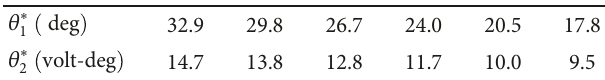
t , v t , and v t ) during closed-loop operation. 4 5 6 Table 1: Constant nominal values of SJA parameters used in